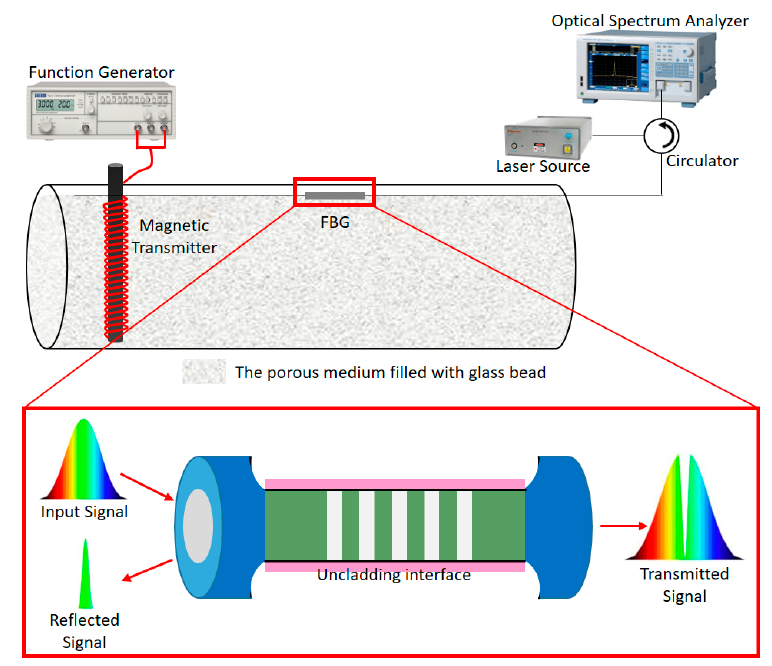
Figure 1. Schematic of fiber Bragg grating (FBG) experiment.